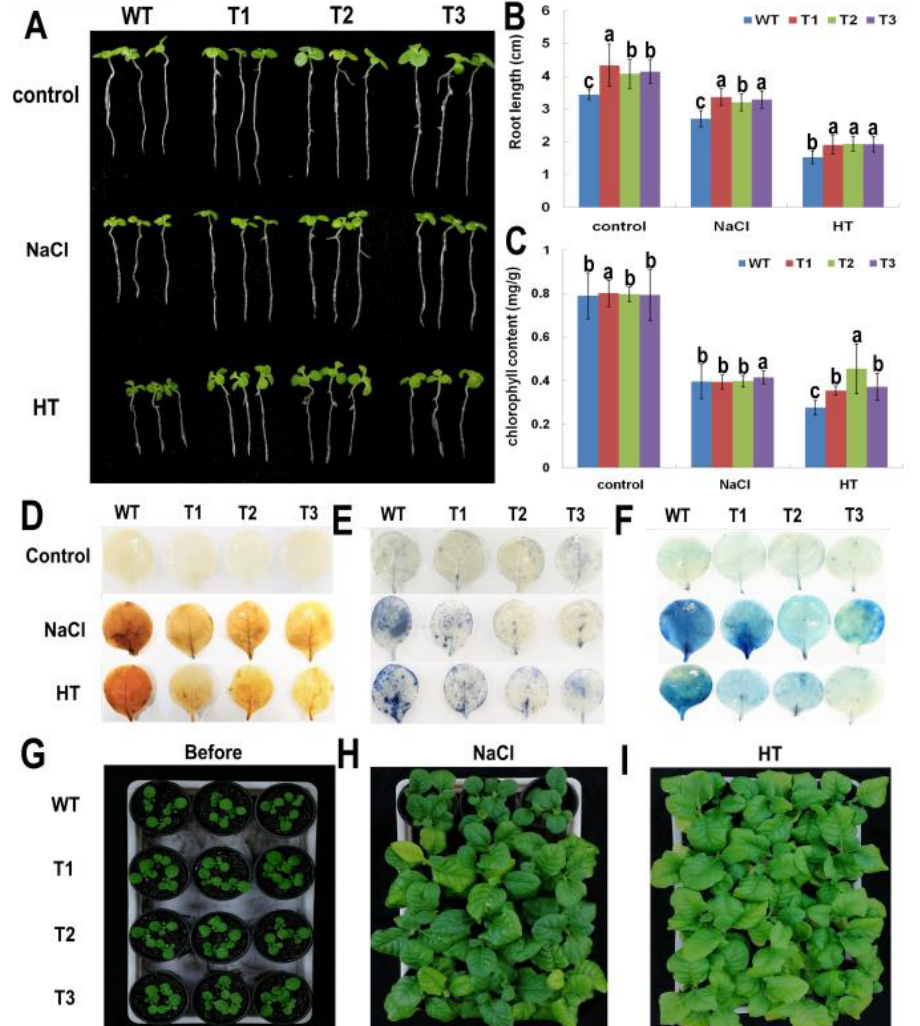
Figure 6. Morphological analysis and histochemical staining of transgenic tobacco lines under NaCl and HT stresses. ( A ) Growth of PsnNAC036 transgenic lines T1, T2, and T3 seedlings in comparison with WT under control, 150 mM NaCl and 37 °C high temperature (HT) conditions. ( B ) Root length assay of the transgenic lines, compared to WT under control, 150 mM NaCl and HT conditions. ( C ) Chlorophyll content of transgenic tobacco lines and WT plants. The statistical analysis was done using a one-way analysis of variance (ANOVA) with a post-hoc with Tukey lines with an alpha value of 0.05. Different letters indicate significant difference between sites. ( D ) 3,3′-Diaminobenzidine (DAB) staining; ( E ) Nitroblue tertazolium (NBT) staining; ( F ) Evans blue staining; ( G ) Four-week-old tobacco plants in soil right before treatments; ( H ) 200 mM NaCl treatment for two weeks; ( I ) HT treatment for two weeks.